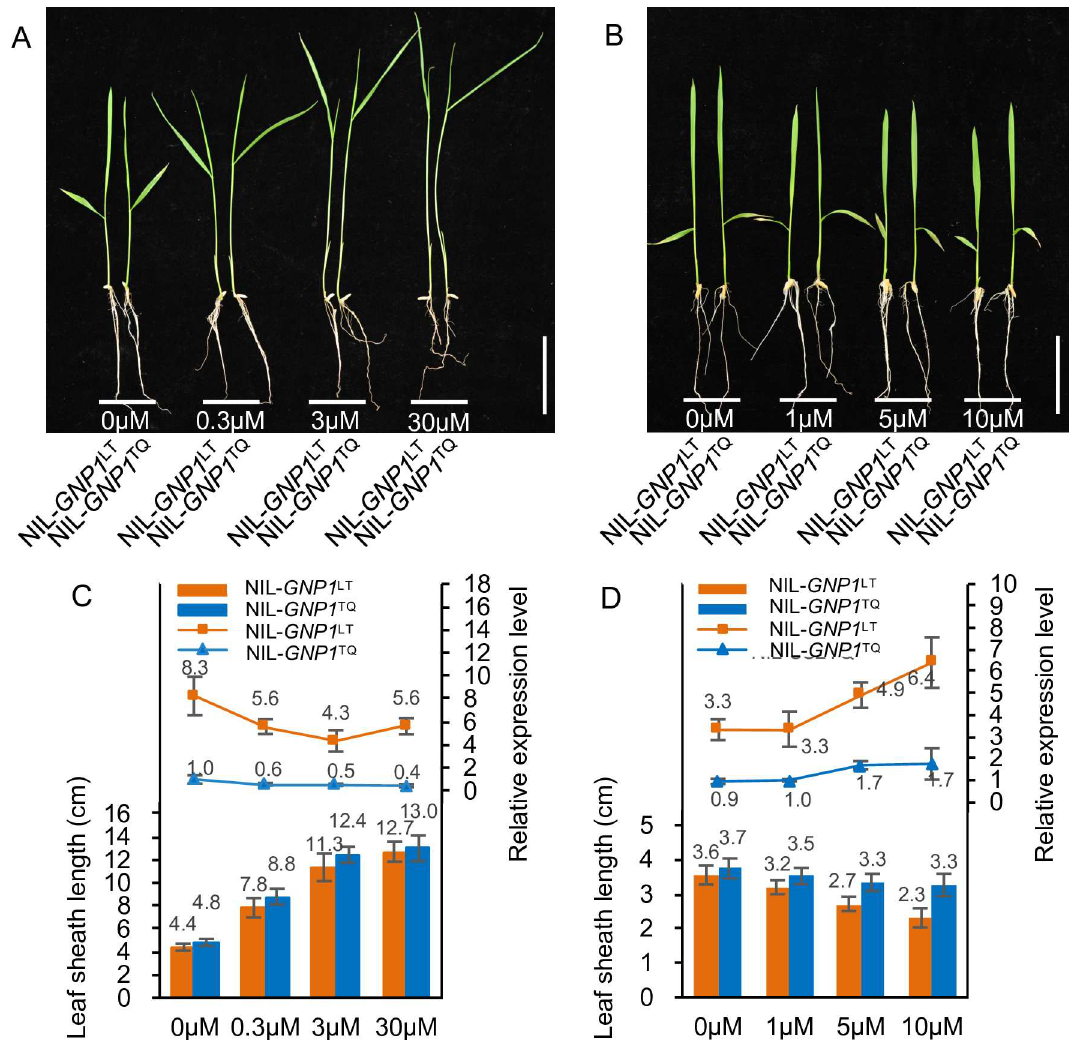
Fig 4. The response of GNP1 to various treatments. (A) Dose-dependent response of leaf sheath length in NIL- GNP1 LT and NIL- GNP1 TQ to GA 3 treatment. Scale bar, 5 cm. (B) Dose-dependent response of leaf sheath length in NIL- GNP1 LT and NIL- GNP1 TQ to uniconazole-P treatment. Scale bar, 5 cm. (C) Comparison of leaf sheath length (n = 48) together with the relative expressionlevels of GNP1 in treated seedlingleaf sheaths (n = 6, each with 8 plants) among different GA 3 treatments for NIL- GNP1 LT and NIL- GNP1 TQ seedlings.Values are means ± s.d. (D) Comparison of leaf sheath length (n = 48) together with the relative expression levels of GNP1 in treated seedling leaf sheaths (n = 6, each with 8 plants) among different uniconazole-P treatments for NIL- GNP1 LT and NIL- GNP1 TQ seedlings. Values are means ±